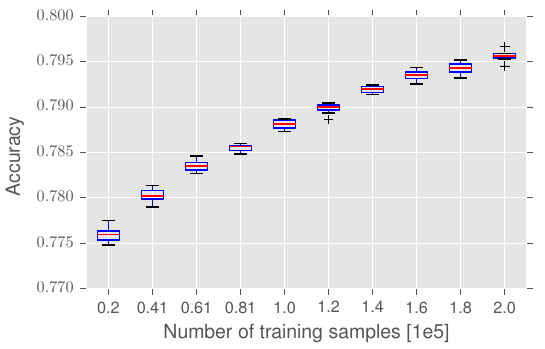
Figure 6. Plot of RDFE driveracceptancemodelaccuracy on a test set (upto 20% of the wholedataset).